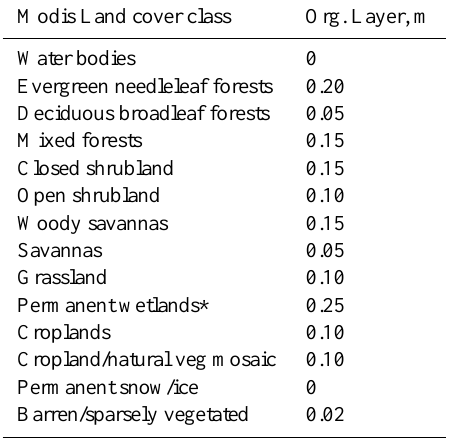
Table 1. Depth of organic layer in the mineral soil partition in each grid cell for different MODIS land cover classes. Based on Bock- heim et al. (1997). The permanent wetlands class does not include